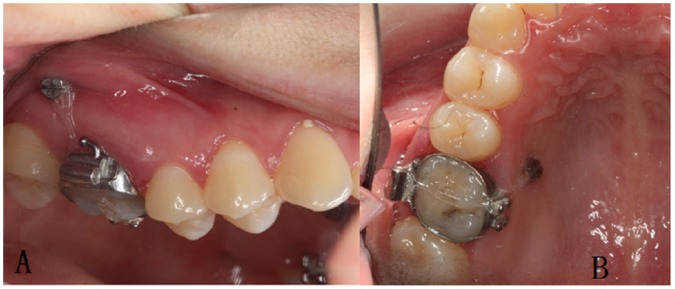
Intra-oral photos of the mini-screw implants.A. The mini-screw implant was placed between the upper first molar and the second molar on the buccal side; B. The mini-screw implant was placed between the first molar and the second premolar on the palatal side.